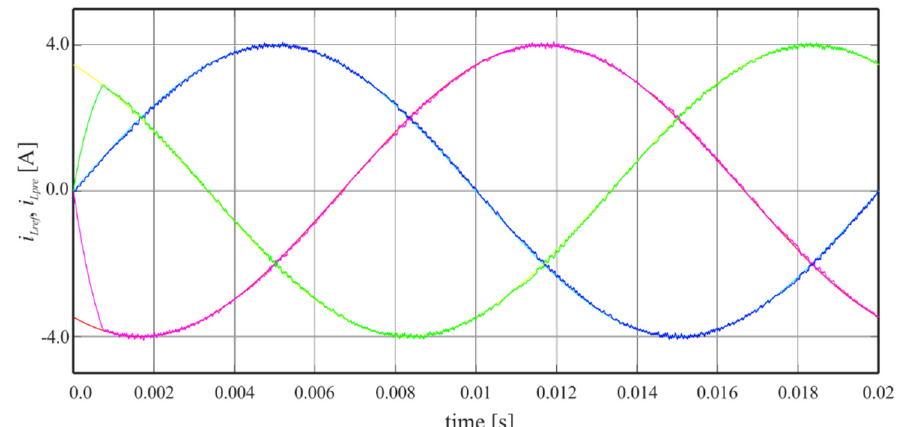
Figure 3. Output and reference currents in matrix converter using Simulink.